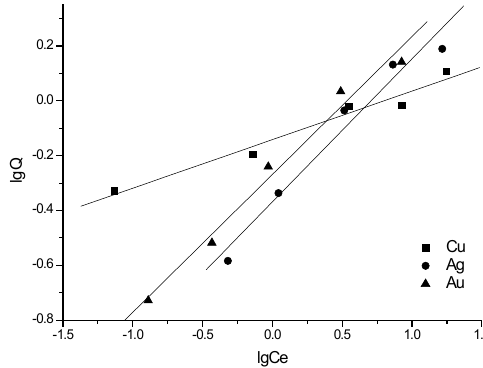
Figure 7. The Freundich isotherms of the sample SG-PS-azo-SA for Cu(II), Ag(I) and